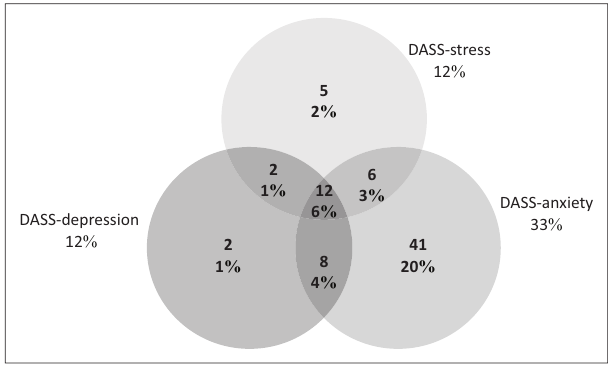
FIGURE 2: Severe and extremely severe D (depression), A (anxiety) and S (stress)